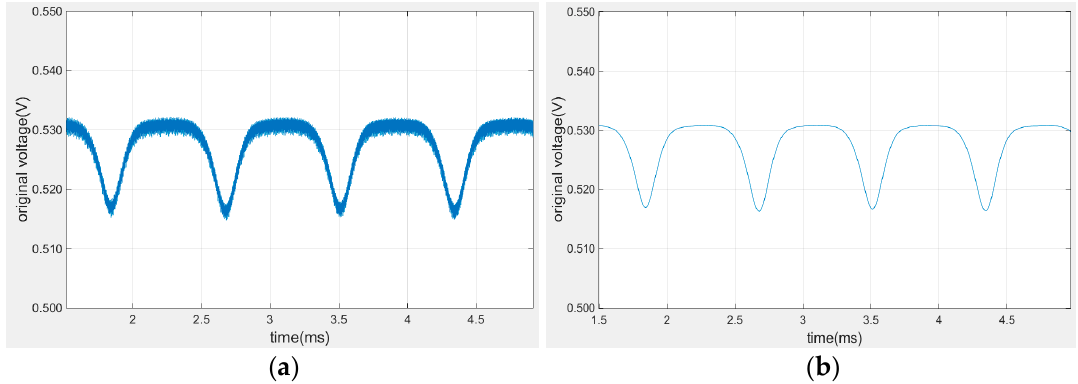
Figure 6. SWD effect comparison; ( a ) signal sequence before SWD; ( b ) signal sequence after SWD.